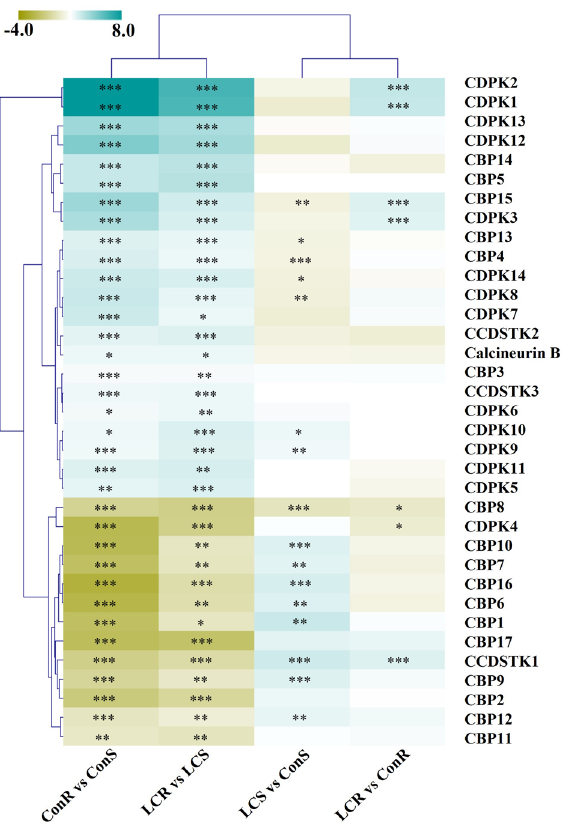
Figure 6. Heatmap of differentially expressed Ca 2+ -signaling genes. Several families of Ca 2+ -signaling genes are differentially regulated between the Ca treatment and root and shoot tissues. CCDSTK, calcium/ calmodulin-dependent_serine/threonine-protein_kinase; CBP, calcium-binding_protein; CDPK, calcium- dependent_protein_kinase. Et_8B_060076, Calcineurin B; Et_4B_036878 CCDSTK1; Et_5A_041770, CCDSTK2; Et_5B_044444, CCDSTK3; Et_1B_010286, CBP1; Et_1B_014273, CBP2;